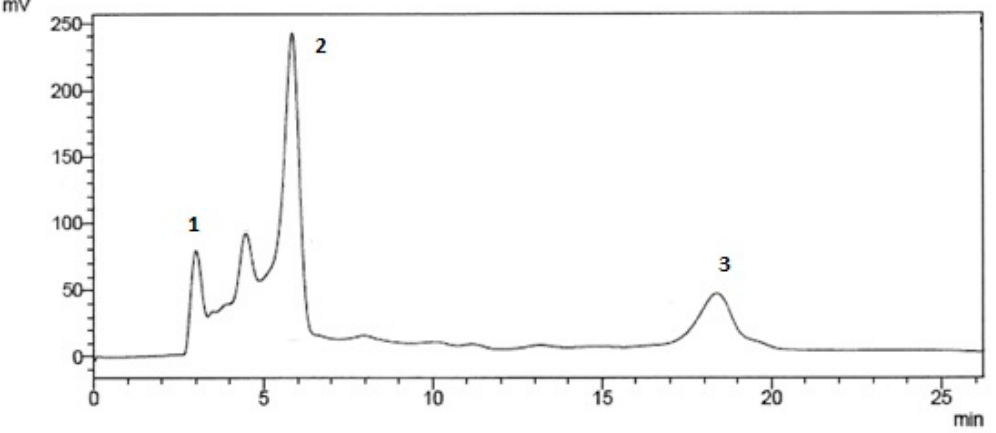
Figure 1. HPLC chromatogram of the extract of C. rhipidophylla berries sample (B) extracted by Soxhlet